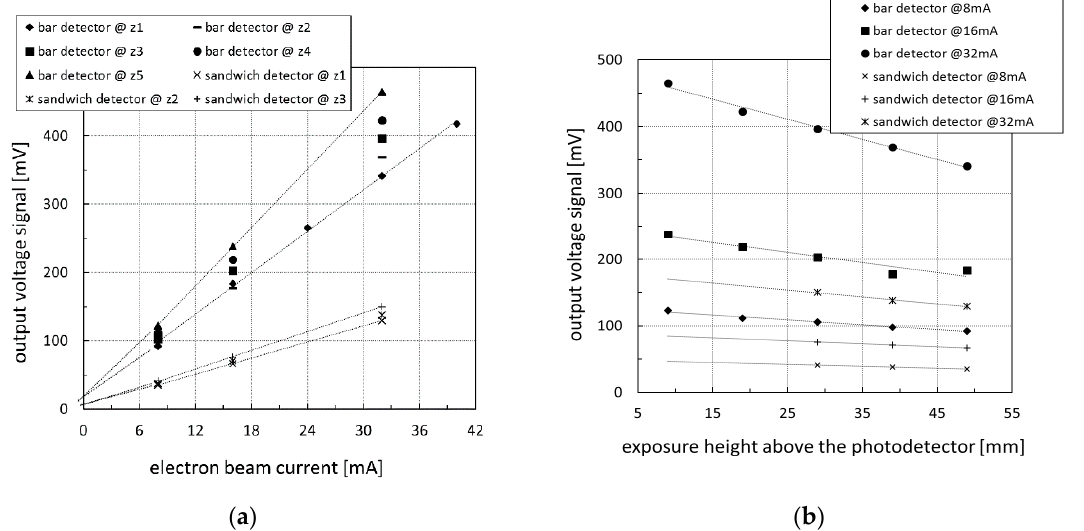
Figure 15. Measured and averaged output voltage signal of LYSO bar and LYSO sandwich multi-plane detectors versus ( a ) various electron beam currents and ( b ) various exposure heights above the photodetector. Table 2. Calculated signal ratios for directly exposed bar versus sandwich detector for various electron beam currents and detector exposure heights z .